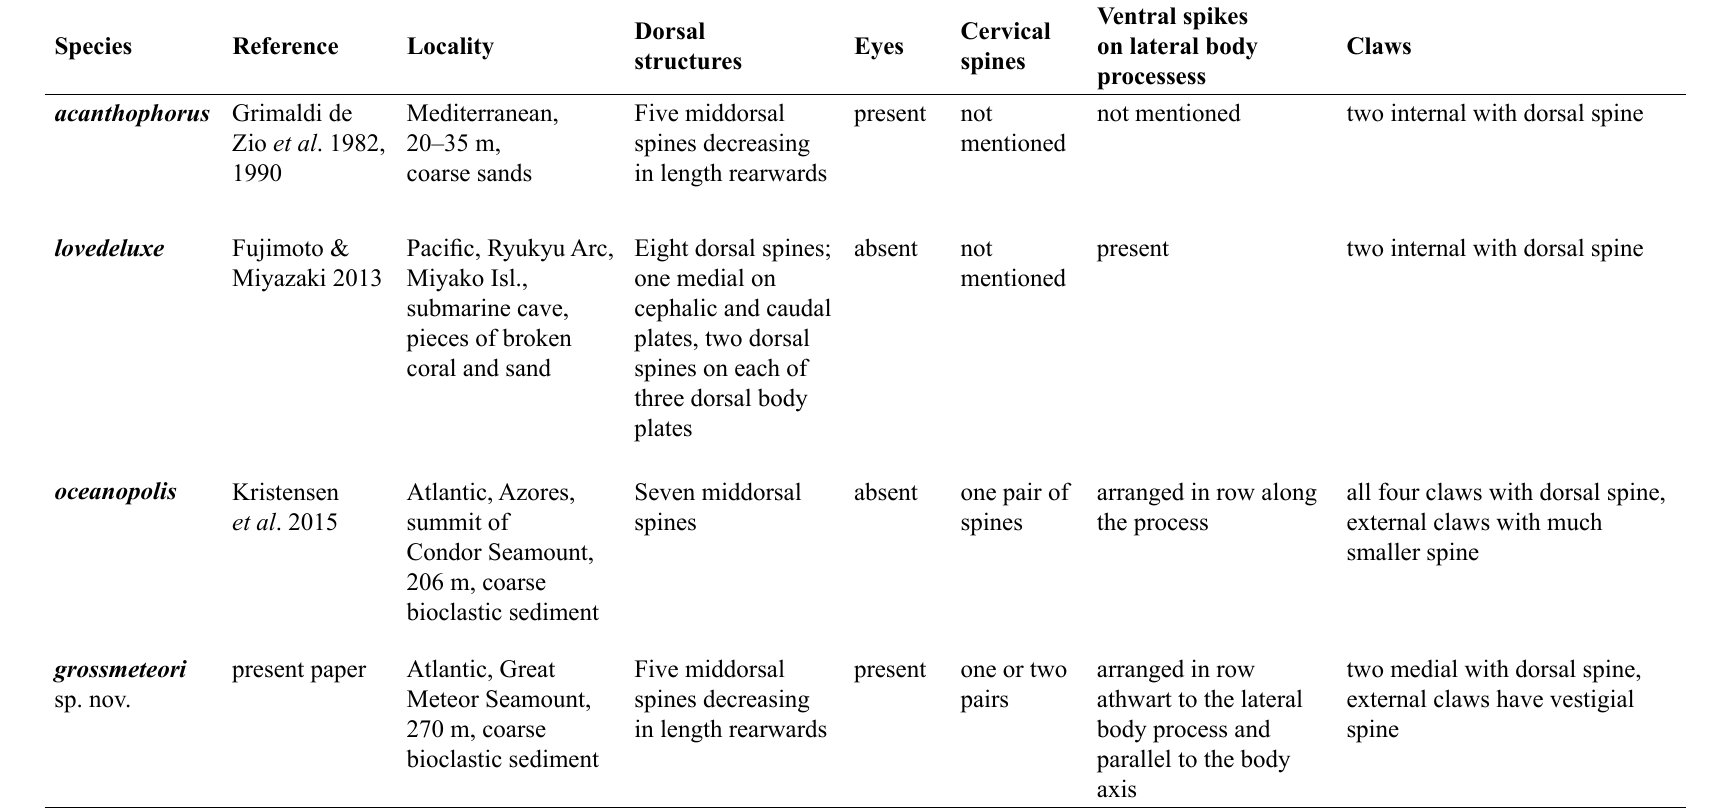
Table 2. Comparison of selected diagnostic characters between species of the genus Neostygarctus Grimaldi de Zio et al ., 1982 based on literature data.